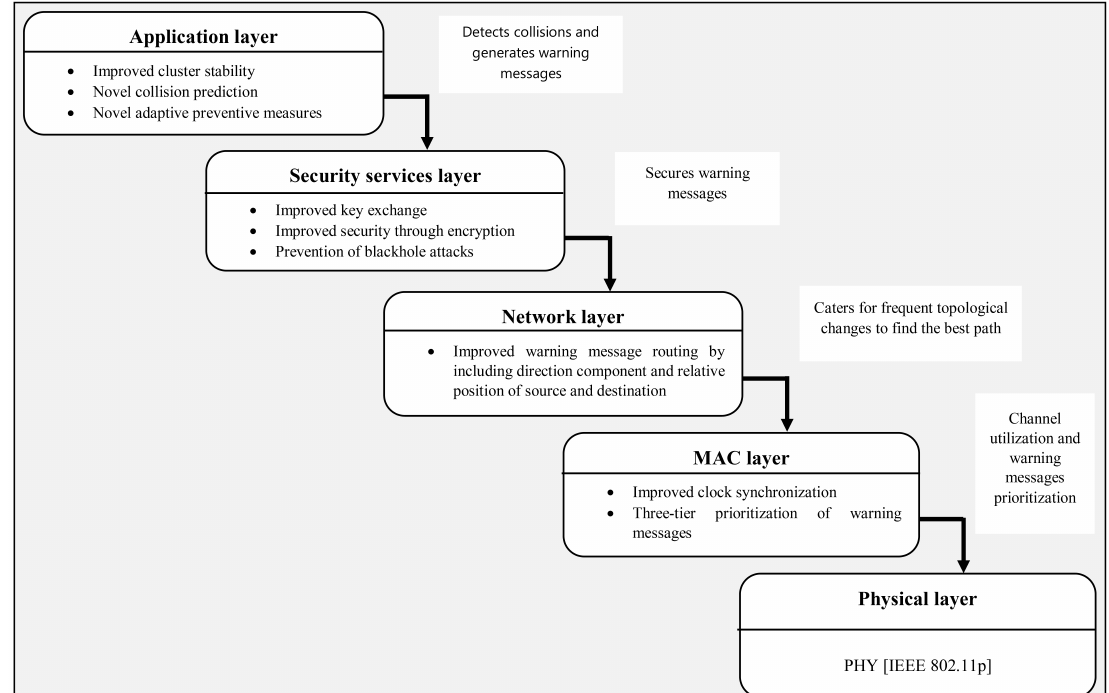
Figure 3. Layer-wise attributes of the proposed DVCA